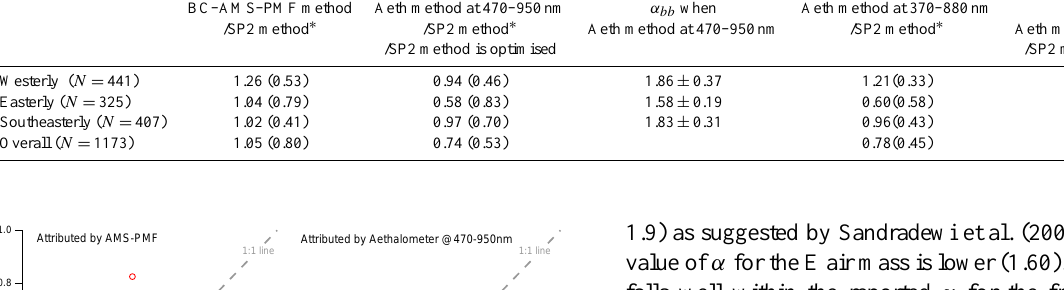
Figure 10. Intercomparisons among different techniques of BC source attribution. The above panel shows the number fraction of BC from a solid fuel burning source which can only be obtained from SP2 attribution. Table 3. A summary of the correlations among different BC mass attribution techniques: the number is the slope of the linear regression and in brackets is r 2 . N denotes the data points used for linear regression; ∗ denotes a linear regression constrained to an intercept of zero. BC–AMS–PMF method Aeth method at 470–950nm